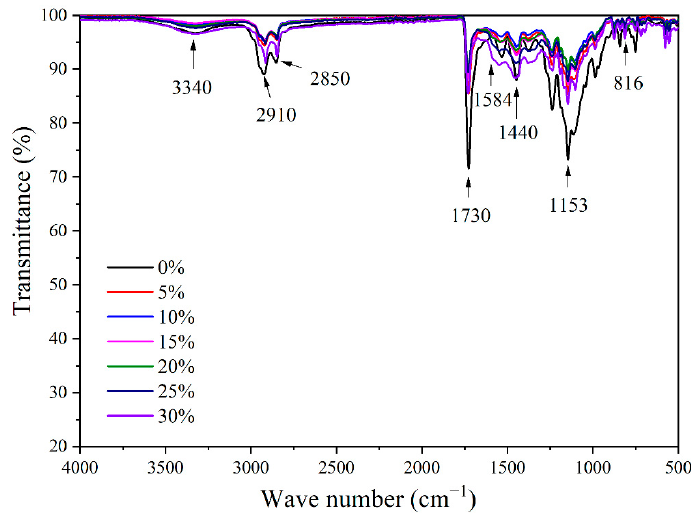
Figure 6. FTIR of topcoats containing different concentrations of fluorane microcapsules. When 1, 2-benzo-6-diethylaminofluorane reacts with an acid chromogenic agent, which results in an electron transfer, the lactone ring of the compound opens and forms a conjugated chromogenic structure when the temperature is lower than the solvent’s melting point [38,39]. The microcapsules turn yellow when the central carbon atom transitions from an sp 3 etherified state to an sp 2 hybrid plane configuration. The solvent turns into a liquid as the system’s temperature rises, and as a result, it separates from the 1, 2-benzo compound. The conjugal structure of quinone achieves a reversible transformation into a lactone ring structure in the liquid state